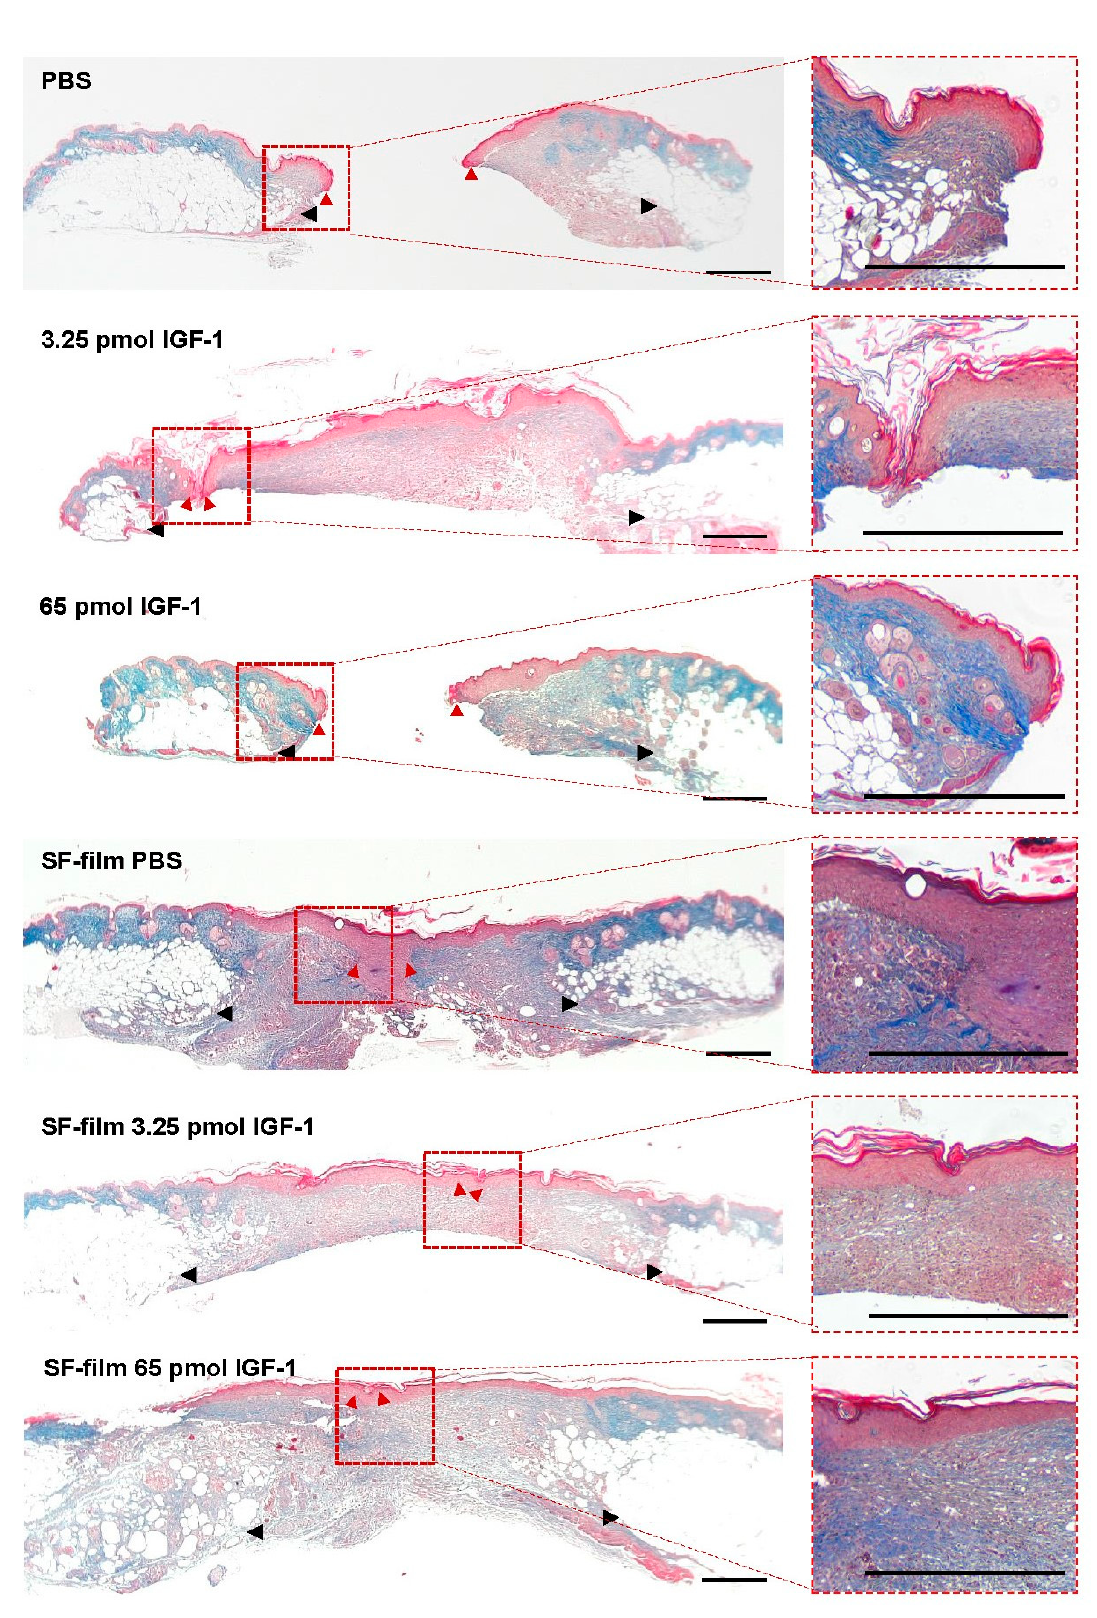
Figure 9. Masson’s trichrome staining of the wound area after different treatments. Tissues at day 13 post-wounding were histologically analyzed. Wound edge, black arrowheads; tips of the epithelial tongue, red arrowheads. The left panel was imaged at 10× magnification and the right panel was at 40× magnification. Scale bars = 500 µm.